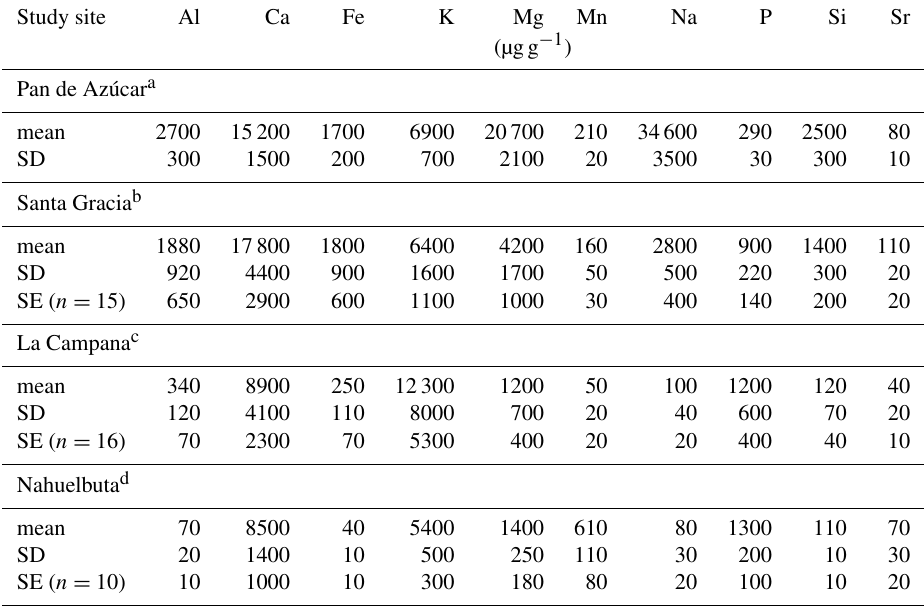
Standard deviation and standard error relate to the variability within the dataset of each ecosystem. Where natural replicates were not available (i.e., in Pan de Azúcar), 10% relative uncertainty has been assumed. a Pan de Azúcar ecosystem composition: 100% Nolona mollis ; 32% and 68% relative leaf and stem growth, respectively, accounting for 5% leaf and 95% stem standing biomass. b Santa Gracia ecosystem composition: 25% each of Asterasia sp., Cordia decandra , Cumulopuntia sphaerica , and Proustia cuneifolia ; 32% and 68% relative leaf and stem growth assumed for all species, respectively, accounting for 5% leaf and 95% stem standing biomass. c La Campana ecosystem composition: 5% each for Aristeguietia salvia and Colliguaja odorifera and 45% each for Cryptocaria alba and Lithraea caustica ; 32% and 68% relative leaf and stem growth assumed for all species, respectively, accounting for 5% leaf and 95% stem standing biomass. d Nahuelbuta ecosystem composition: 60% Araucaria araucana , 10% Chusquea culeou , and 30% Nothofagus antarctica ; 48% and 52% relative leaf and stem growth assumed for Araucaria araucana , respectively, accounting for 16% leaf and 84% stem standing biomass; 32% and 68% relative leaf and stem growth assumed for Chusquea culeou and Nothofagus antarctica , respectively, accounting for 5% leaf and 95% stem standing